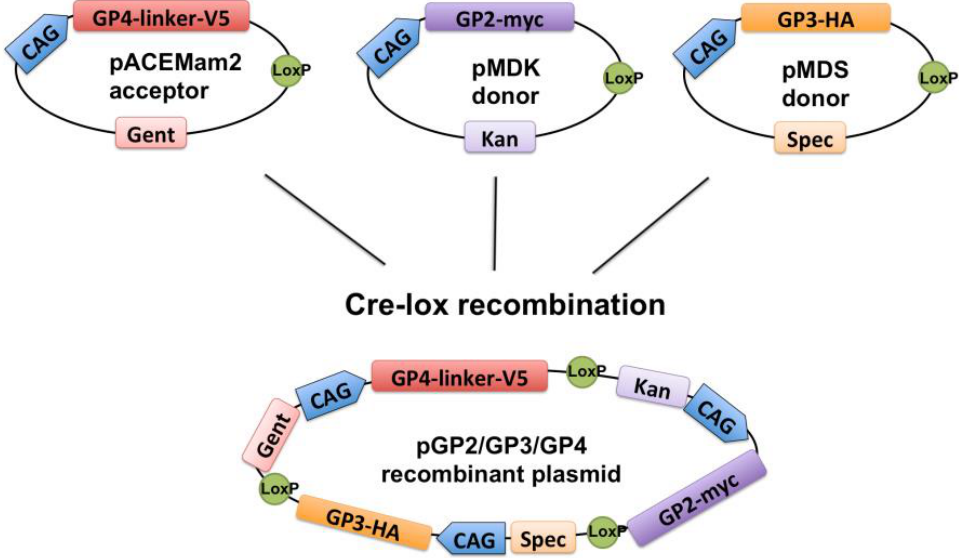
Figure 1. Scheme of MultiMam plasmid construction encoding the EAV spike, pGP2/GP3/GP4. Genes were cloned into one acceptor vector and two donor vectors. pACEMam2 with GP4-linker-V5 was multiplied in DH5alpha E. coli. Donor vectors GP2-myc in pMDK and GP3-HA in pMDS were multiplied in the pir+ E. coli strain. Plasmids were combined with Cre lox-recombination. Note that the depicted recombinant plasmid is just one possible combination after cre-lox recombination, and the obtained vector was not sequenced in full length to validate the order of the genes. CAG; CAG promotor, Gent: gentamycin, Kan: kanamycin, Spec: spectinomycin, LoxP: recombination sequence site.